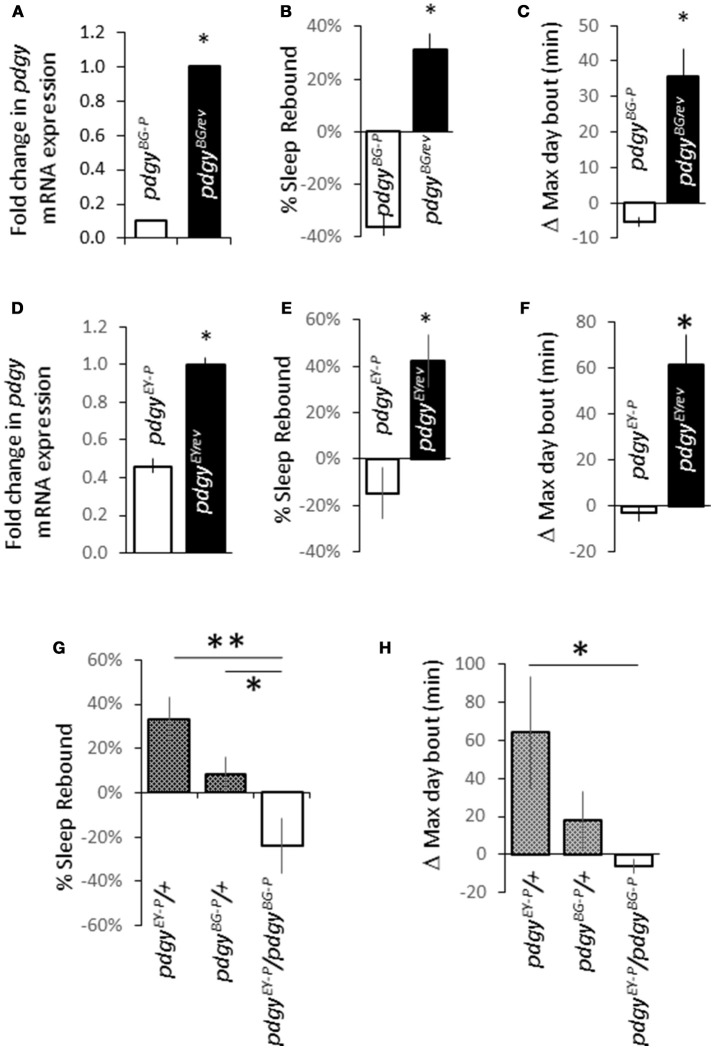
Disruption in pdgy expression alters the response to sleep deprivation. (A) Levels of pdgy mRNA are decreased in pdgyBG02662 (pdgyBG−P) flies compared to the background control, pdgyBGrev (n = 3 groups of 5 pooled flies for each genotype, p < 0.05 by Students t-test). (B) The amount of sleep recaptured after sleep deprivation is significantly decreased when pdgy is disrupted (n = 49 pdgyBG−P and n = 39 pdgyBGrev). (C) The individual change in the maximum day bout was increased in the pdgyBGrev compared to the pdgyBG−P. (D) A second P-element near the pudgyBG−P insertion and in a different background, pdgyEY02124 (pdgyEY−P) has decreased levels of pdgy RNA levels compared to the background controls, pdgyEYrev. (E) The sleep homeostatic response is muted in pdgyEY−P (n = 40) compared to the background control pdgyEYrev (n = 43). (F) The average increase in the maximum day bout is increased between the pdgyEY−P and the pdgyEYrev. (G,H) To determine if there was something in the background responsible for the sleep phenotype in the background of the two strains of flies, we ran a complementation test. pdgyEY−P/+ (n = 16) and pdgyBG−P/+ (n = 14) showed a positive response to sleep deprivation while the pdgyEY−P/pdgyBG−P (n = 13) heterozygote has a significantly lower sleep rebound (G) and maximum day bout on the day following sleep deprivation (H). *p < 0.05, **p < 0.01.